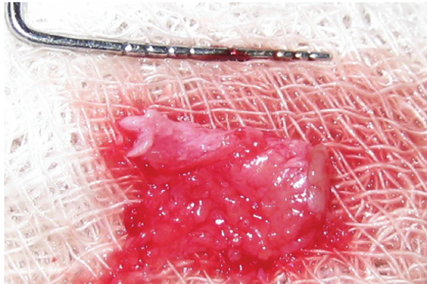
Figure 3: Harvested connective tissue